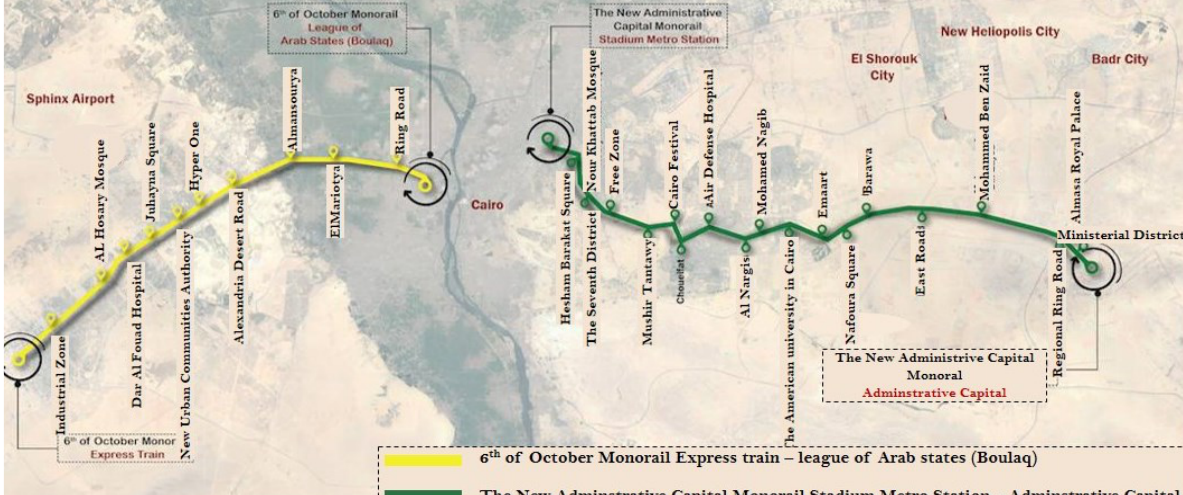
Figure 6. The monorail will run 70 trainsets on two lines east and west of Cairo at a speed of 80km/h (Hill International)- source (Global Construction Review,